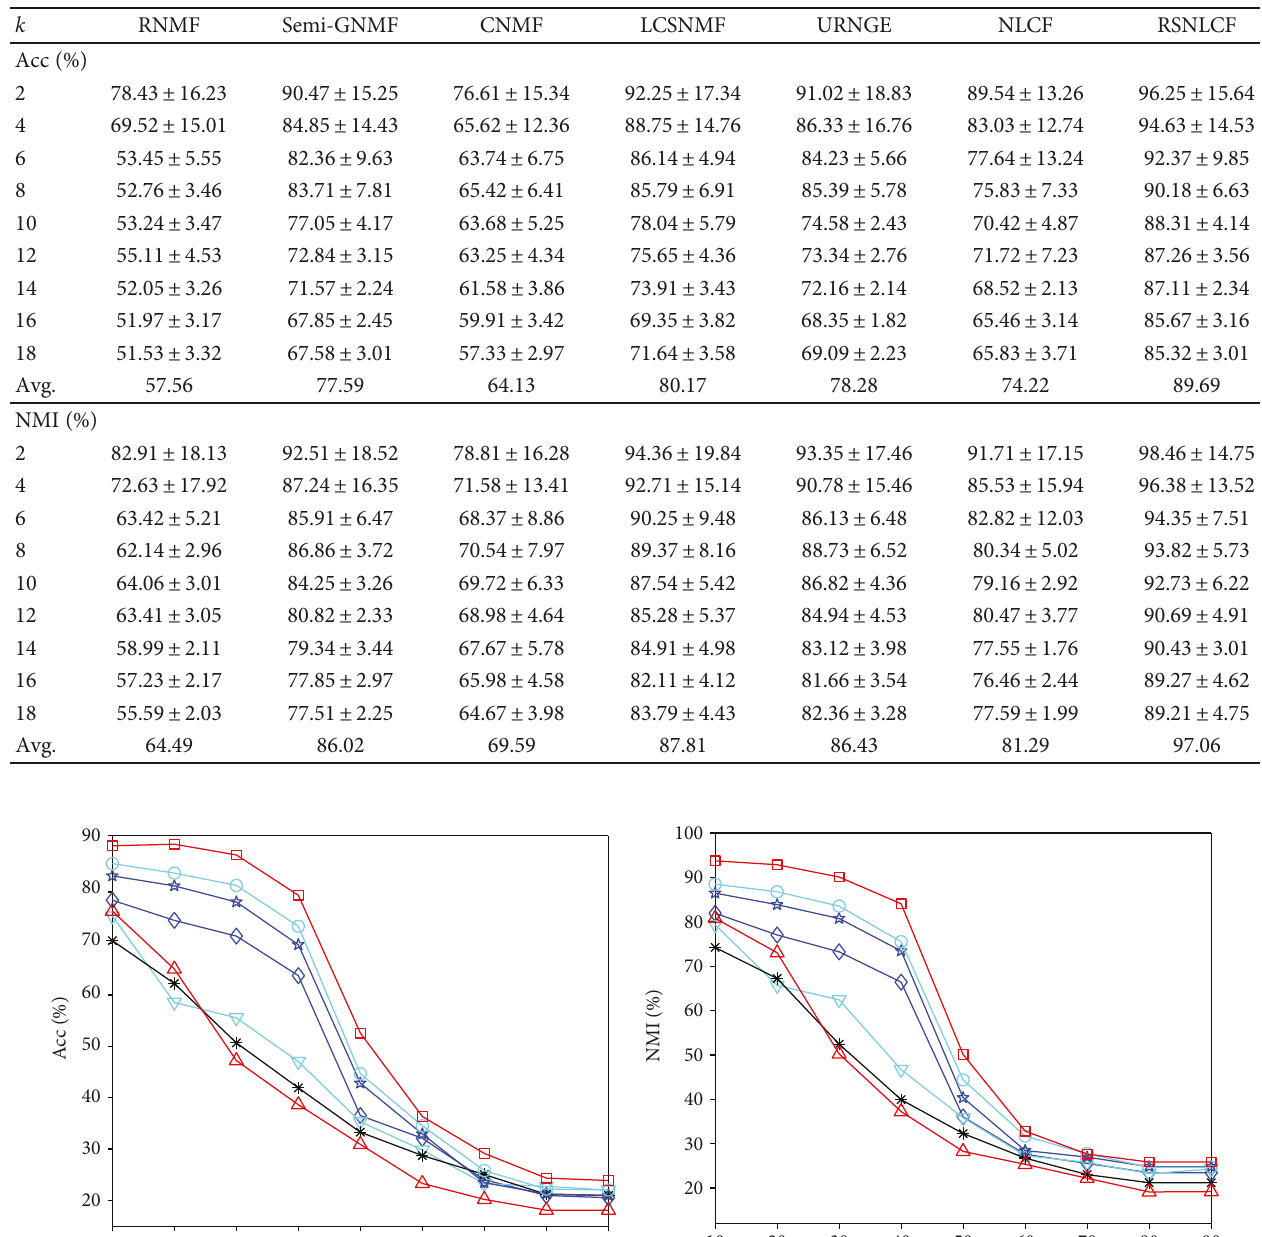
Table 1: Clustering performance on the extended YaleB dataset.